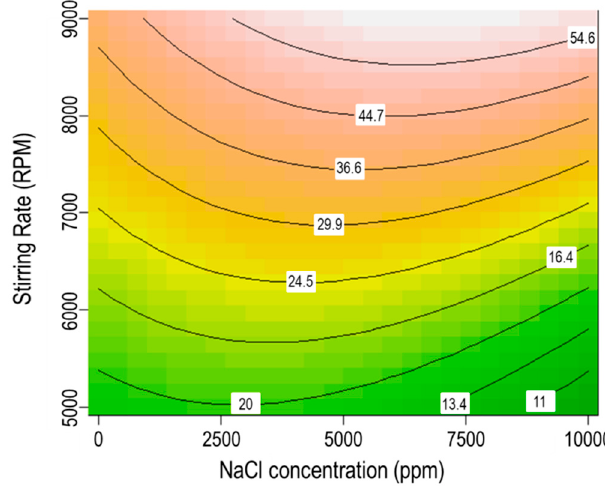
Figure 10. Interaction between stirring rate and salinity at XG polymer concentration = 2500 (ppm) and SDS surfactant concentration = 2500 (ppm).